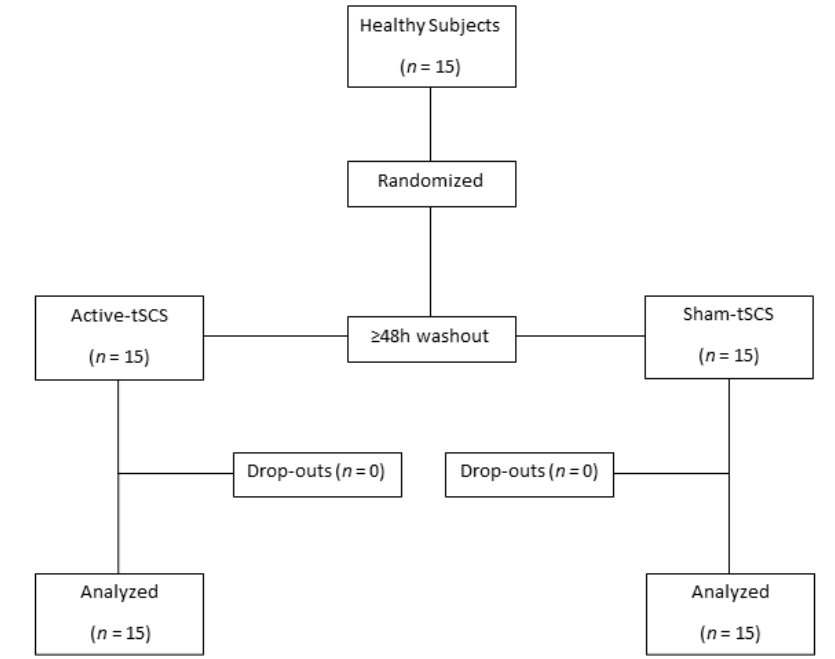
Figure 1. Consolidated Standards of Reporting Trials (CONSORT) flow diagram. Table 1. Neurophysiological assessment at baseline time for each session.